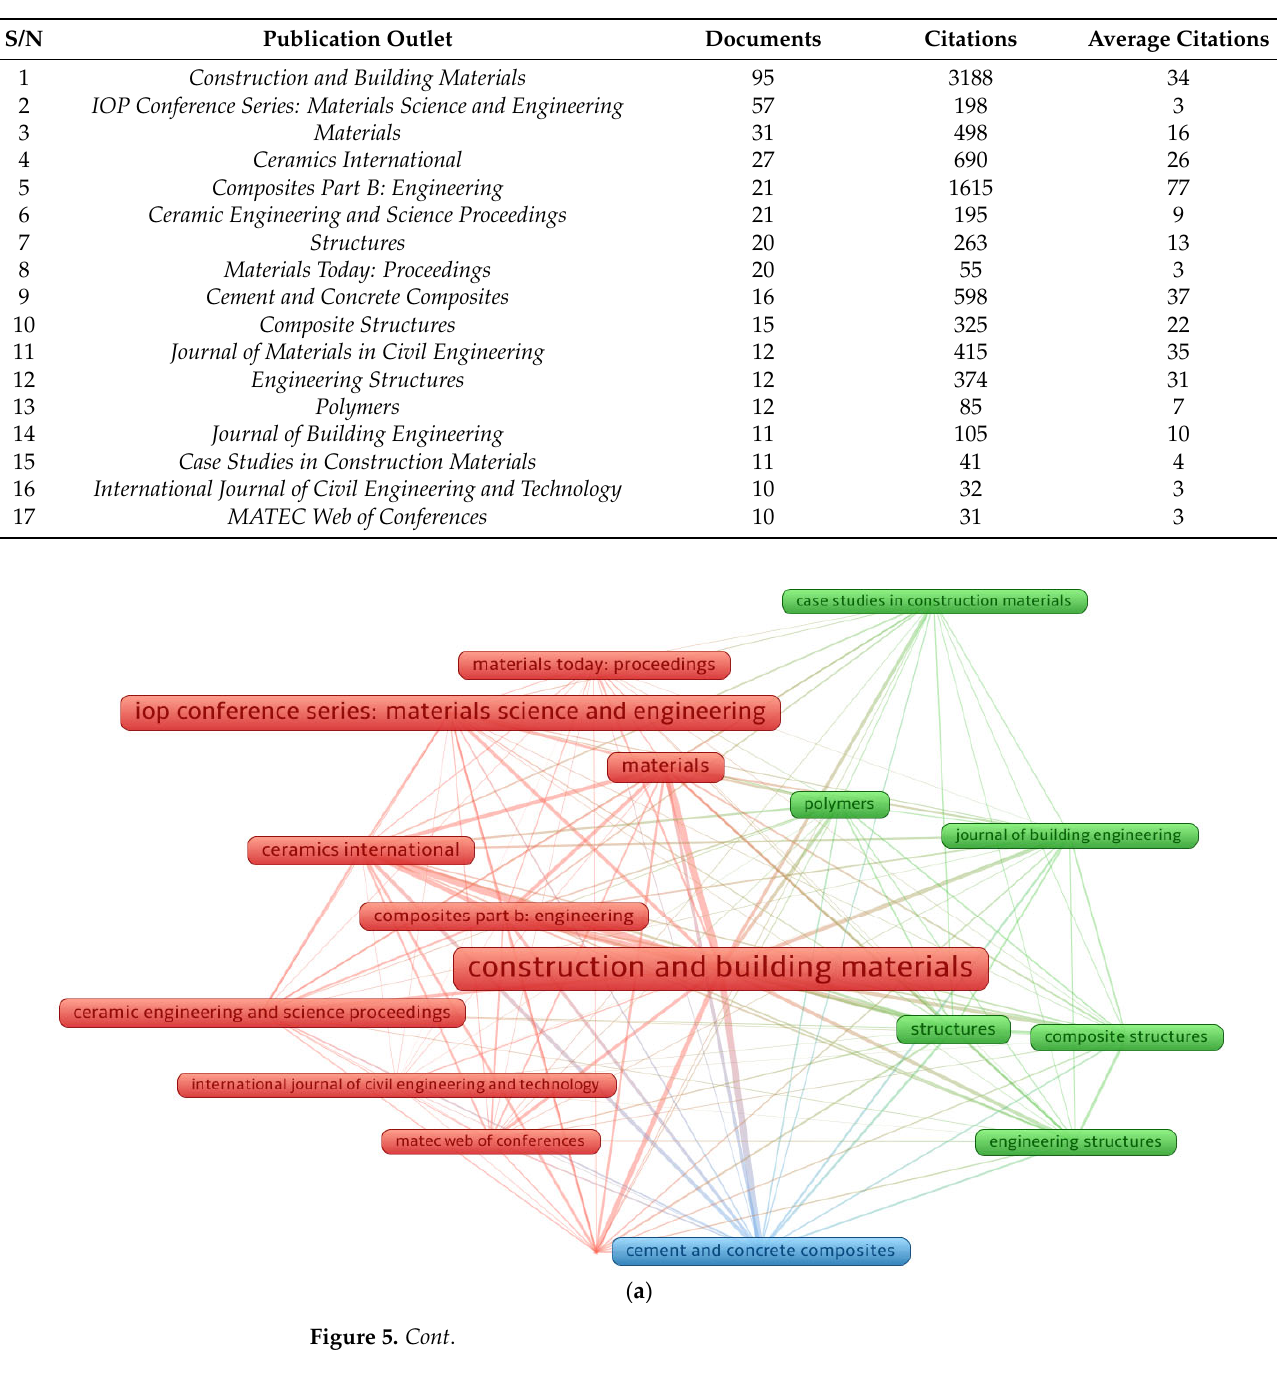
( b ) Figure 5. Systematic map of publication outlets: ( a ) network map; ( b ) density map.